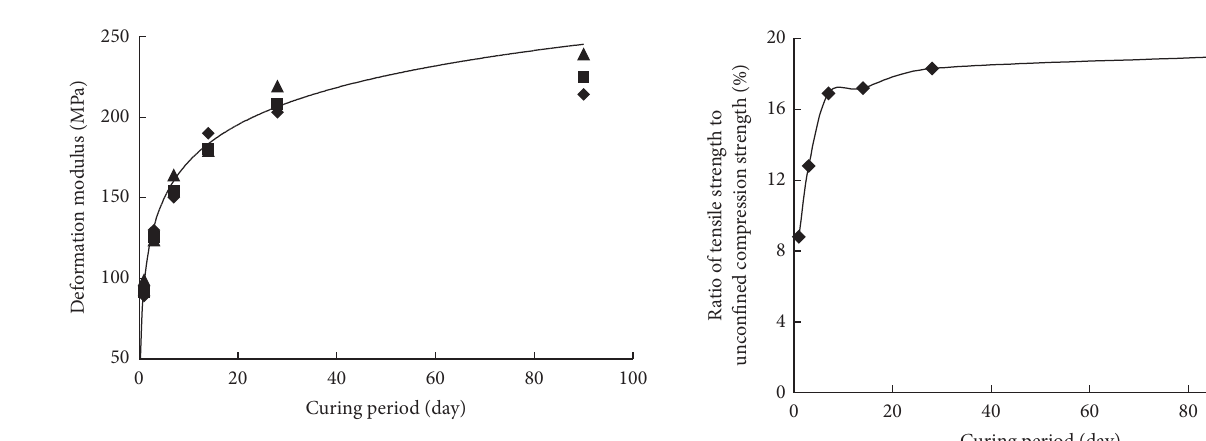
Figure 5: Relationship of deformation modulus-curing period.